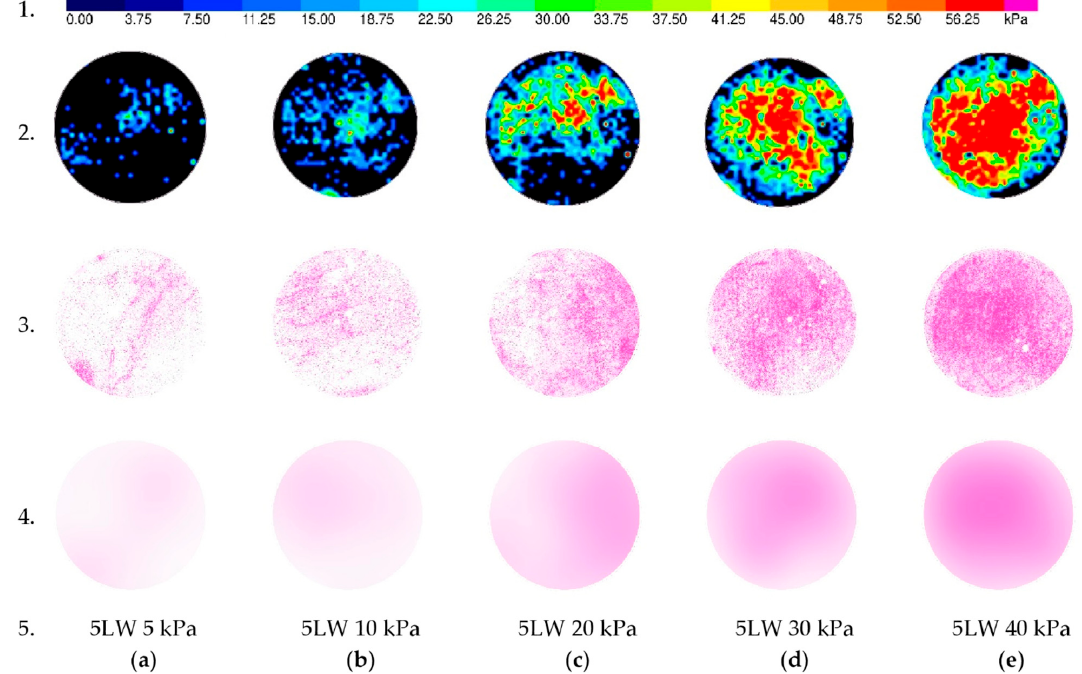
Figure 12. Comparison of contact stresses obtained from tactile and color film sensor 5 LW due to different applied stress. Row 1. Pressure Legend, Row 2. Pressure from tactile sensor results, Row 3. Raw outcomes from color film sensors; Row 4. Average stress on the surface obtained from color film sensors; Row 5. Type of color film sensor and applied stress; ( a ) 5 kPa; ( b ) 10 kPa; ( c ) 20 kPa; ( d ) 30 kPa; ( e ) 40 kPa.